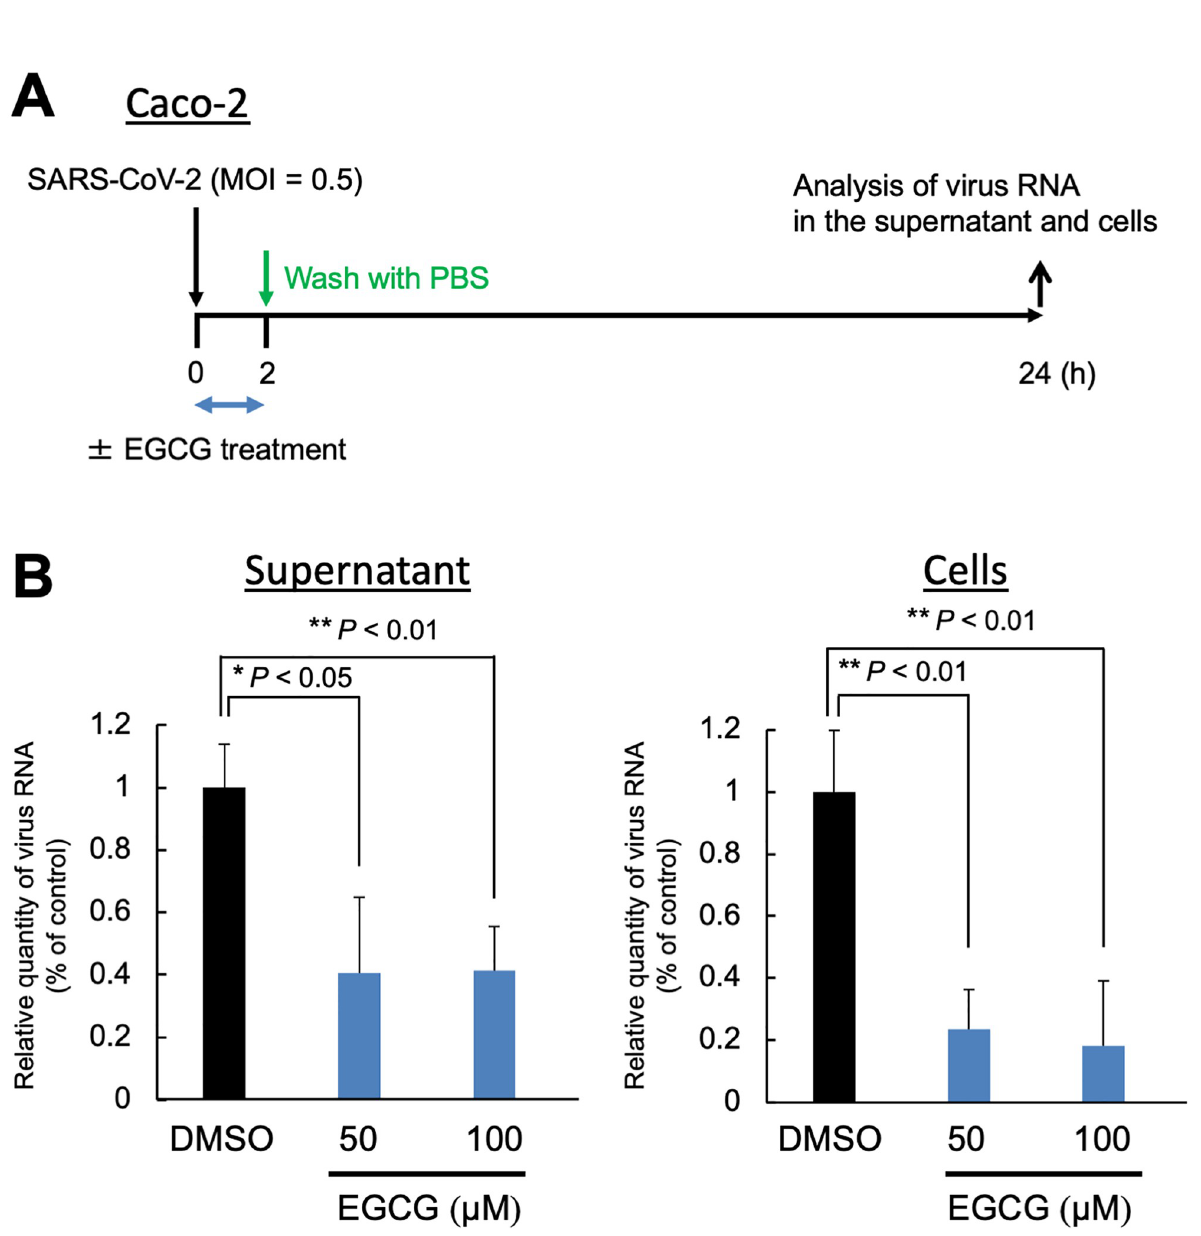
Fig 5. Epigallocatechin gallate (EGCG) inhibits severe acute respiratory syndrome coronavirus 2 (SARS-CoV-2) infection and replication in Caco-2 cells. ( A ) Schematic outline of the experimental procedure. SARS-CoV-2 (MOI 0.5)-infected Caco-2 cells were co-cultured with EGCG at a final concentration of 50 or 100 μ M. At 2 hpi, the cells were washed with phosphate-buffered saline thrice, and fresh medium was added. At 24 hpi, the cell culture supernatant and cell lysate were collected, and the amount of viral RNA was analyzed by real-time reverse transcription-polymerase chain reaction (RT-qPCR). ( B ) Measurement of the SARS-CoV-2 growth inhibition by EGCG determined by RT-qPCR of the nucleocapsid region of the SARS-CoV-2 genome using the supernatant (left) or cells (right). Values are presented as a percentage of control (mean ± SD). Asterisks indicate the significant difference compared with the dimethyl sulfoxide–treated control ( �� p < 0.01, � p <